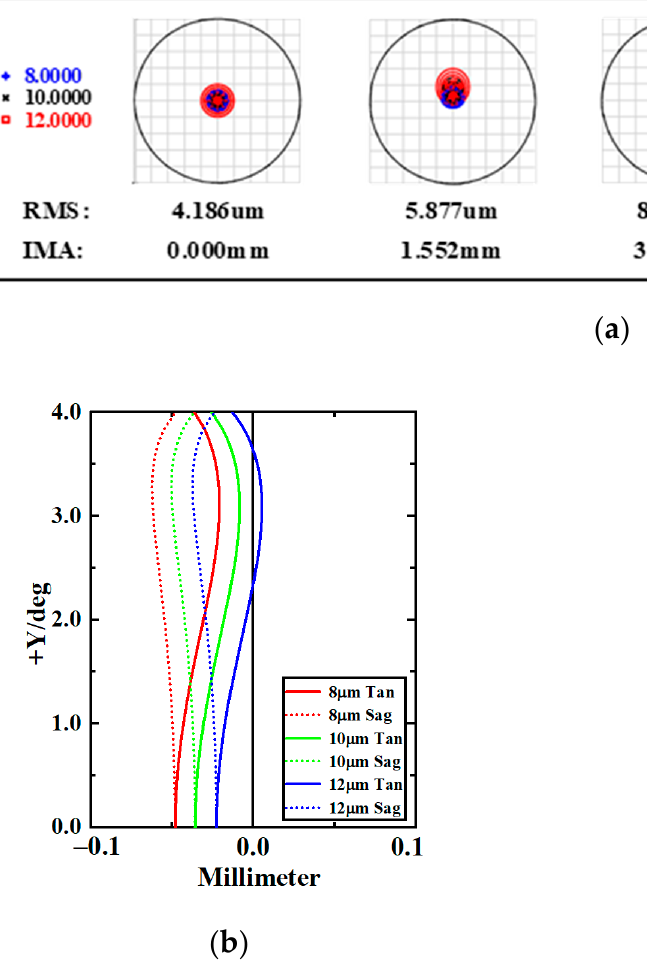
Figure 6. The schematic diagram of the initial structure of the four-reflection optical system. Suppose the object is infinite, that is